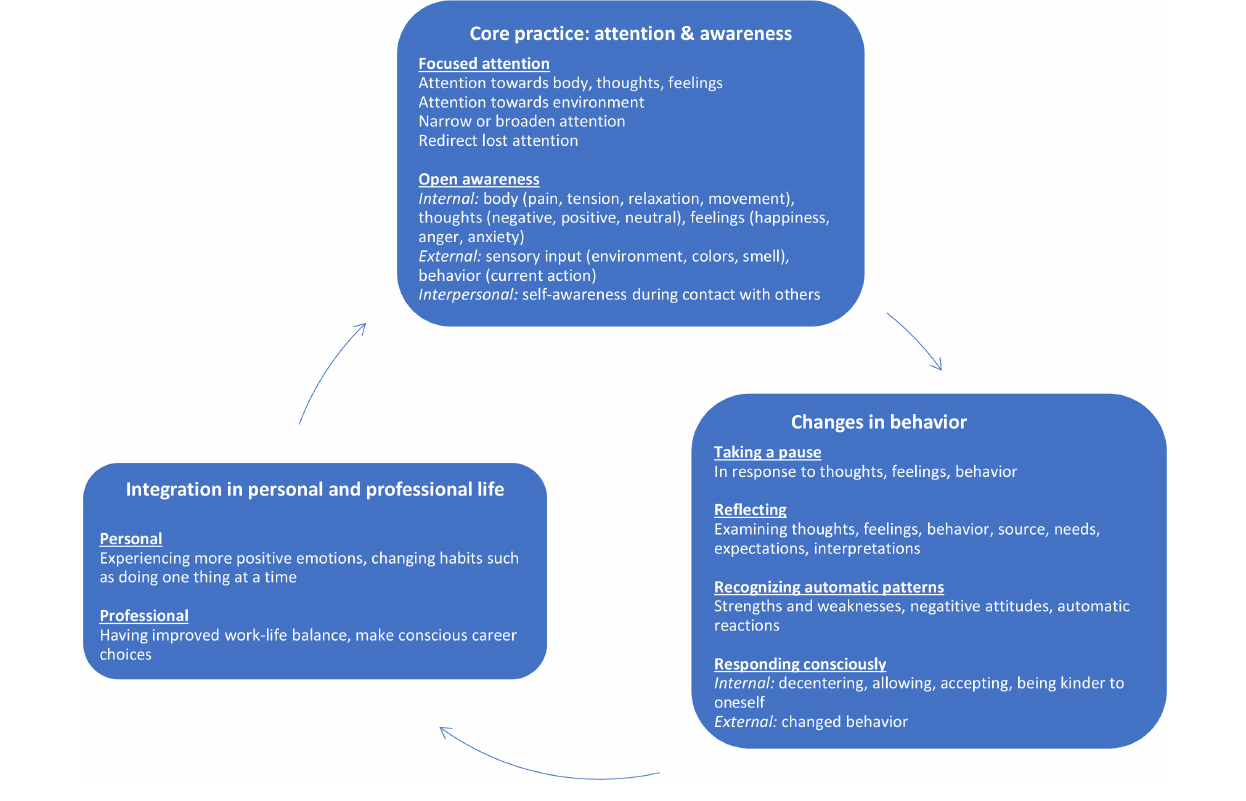
FIGURE 1 | Factors associated with incorporation of mindfulness